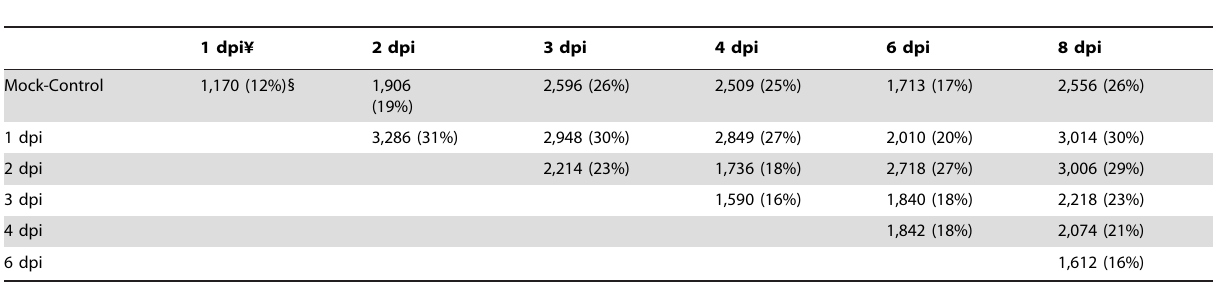
Table 1. Number of genes differentially expressed between different time points.